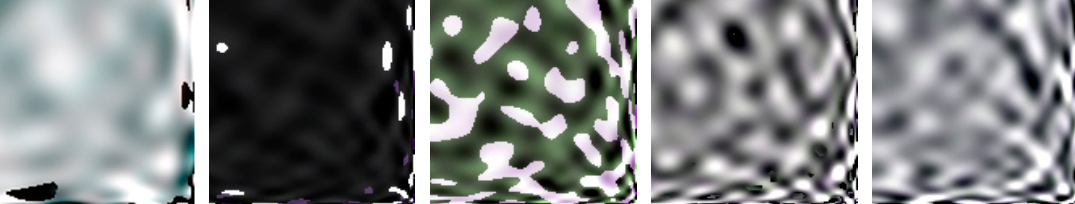
Figure 8. Synthetic hyperspectral scenes.